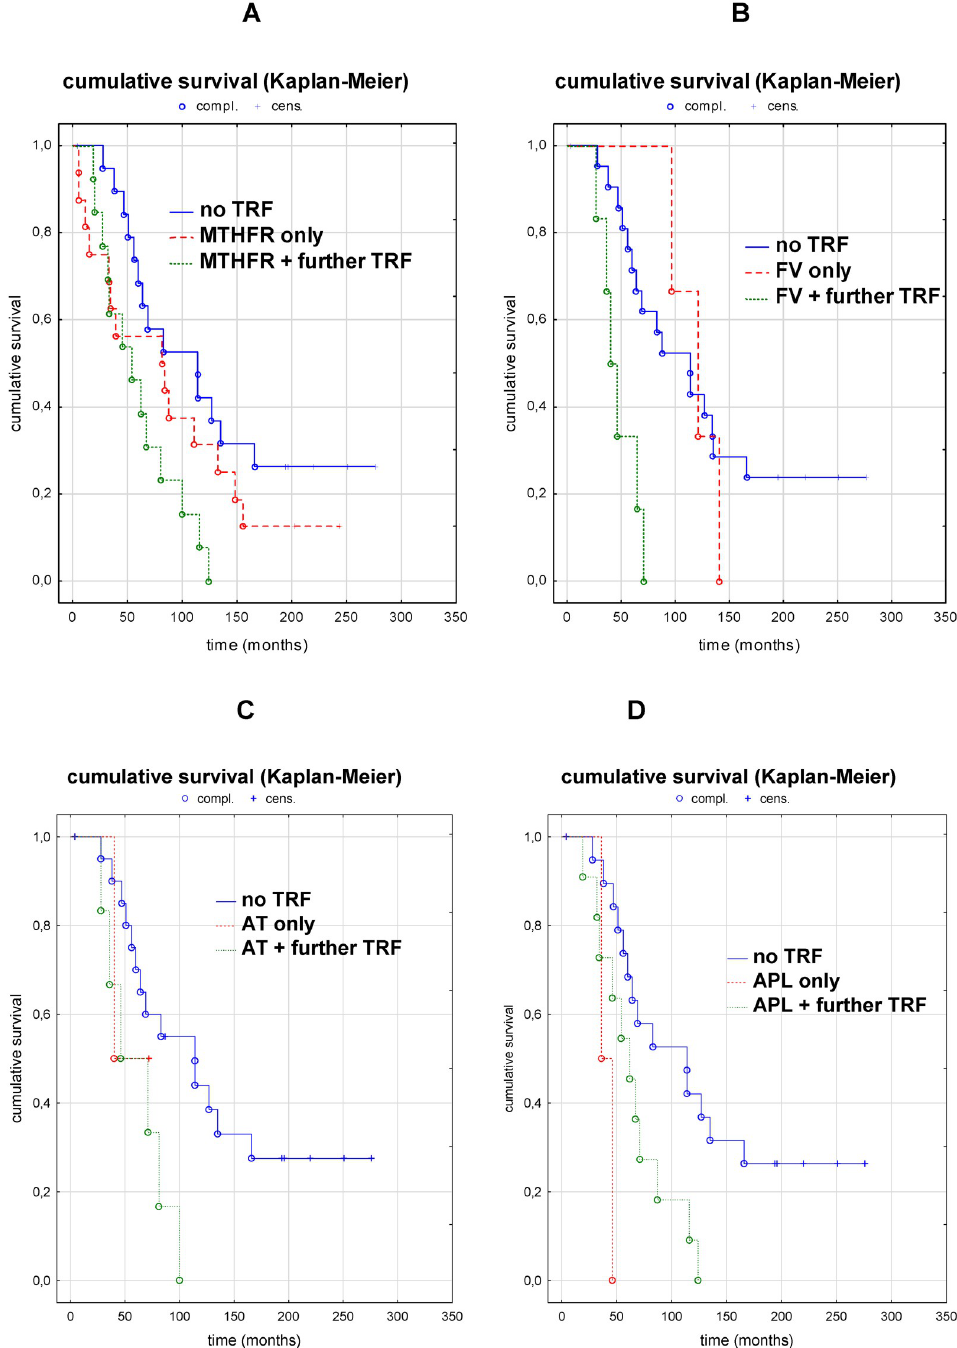
Fig 5. Survival analysis (Kaplan–Meier estimate and log-rank test) of patients for thrombophilic risk factors (TRFs) in detail. (A) MTHFR: Survival tended to be shorter in patients with only a MTHFR mutation (MTHFR only) than in patients without a TRF, but without statistical significance, whereas survival was significantly shorter in patients with a further coagulation disorder (MTHFR + further TRF) than in patients without a TRF ( P < 0.02). (B) Factor V (FV) mutation: Survival was not significantly different between patients with only a FV mutation (FV only) and patients without a TRF, whereas survival was significantly shorter in patients with a further coagulation disorder (FV + further TRF) than in patients without a TRF ( P < 0.05). (C) Antithrombin (AT) deficiency: Survival was not significantly different between patients with only an AT deficiency (AT only) and patients without a TRF, whereas survival tended to be shorter in patients with a further coagulation disorder (AT + further TRF) than in patients without a TRF ( P = 0.054).